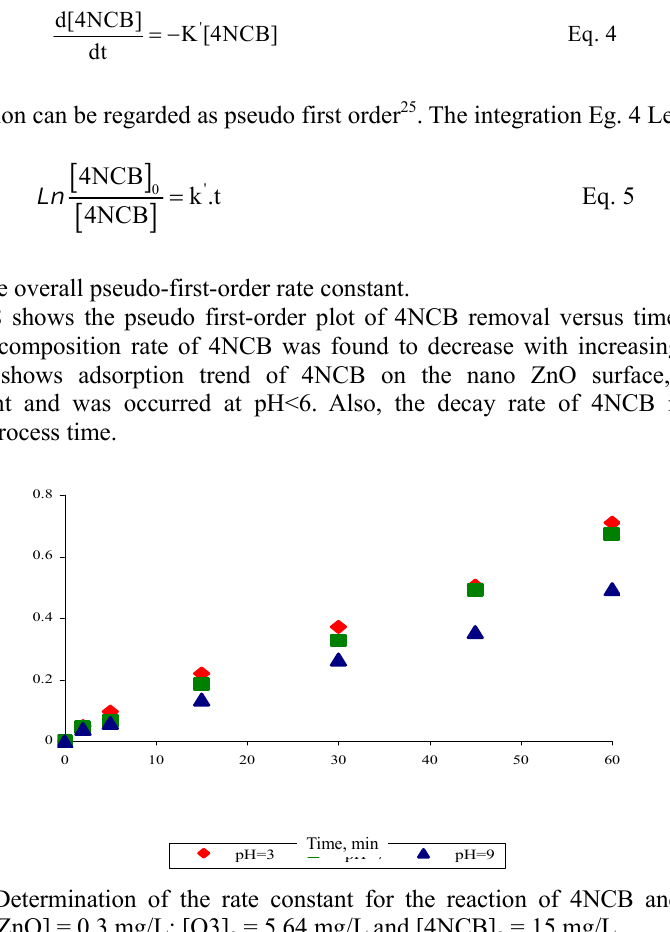
= 5.64 mg/L and [4NCB] o